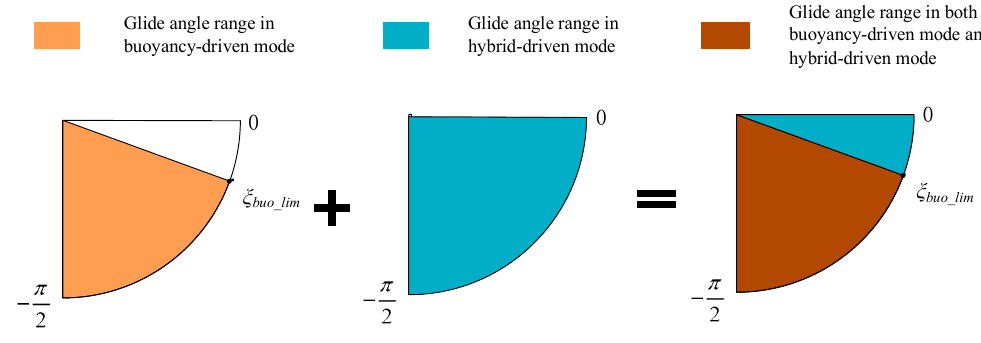
Figure 7. Glide angle range of the zero-angle-of-attack glider.